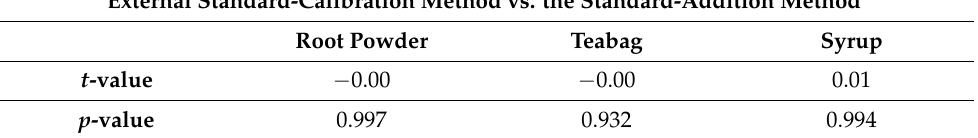
Table 5. The t - and p -values for comparing the difference between the external standard-calibration and standard-addition methods.